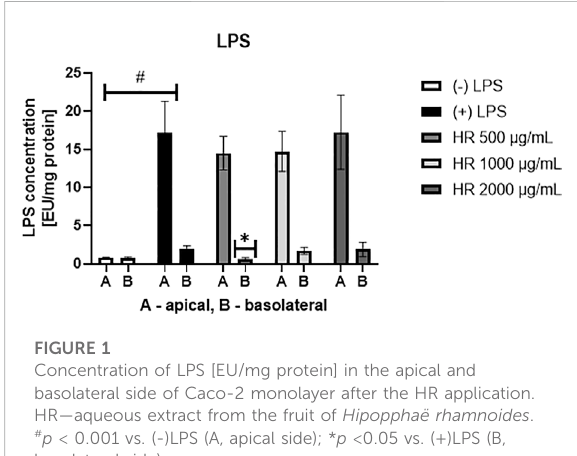
basolateral side of Caco-2 monolayer after the HR application. HR — aqueous extract from the fruit of Hipopphaë rhamnoides